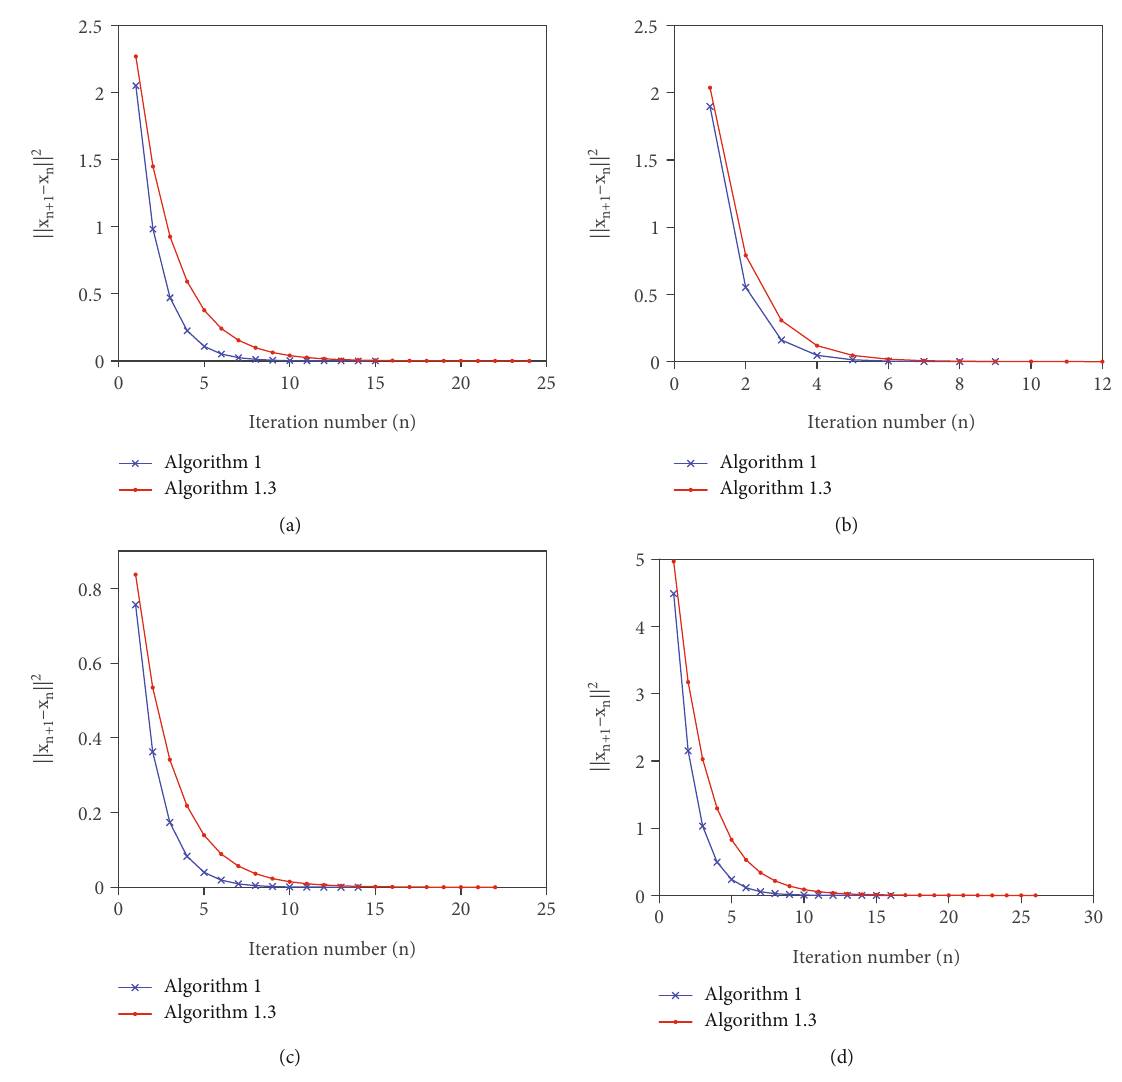
Figure 1: Example 23: (a) Case I; (b) Case II; (c) Case III; (d) Case